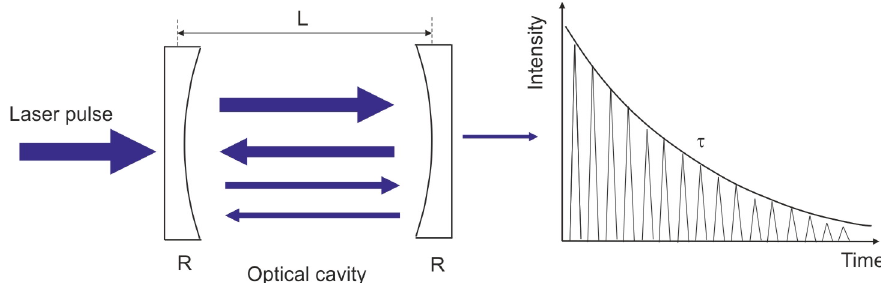
Figure 10. Idea of CRDS